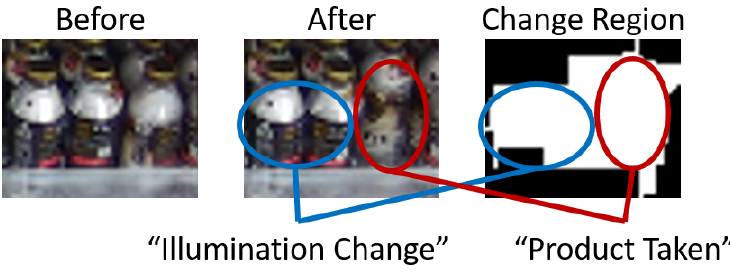
Figure 17. Example in which different kinds of change regions are detected as one change region since those regions